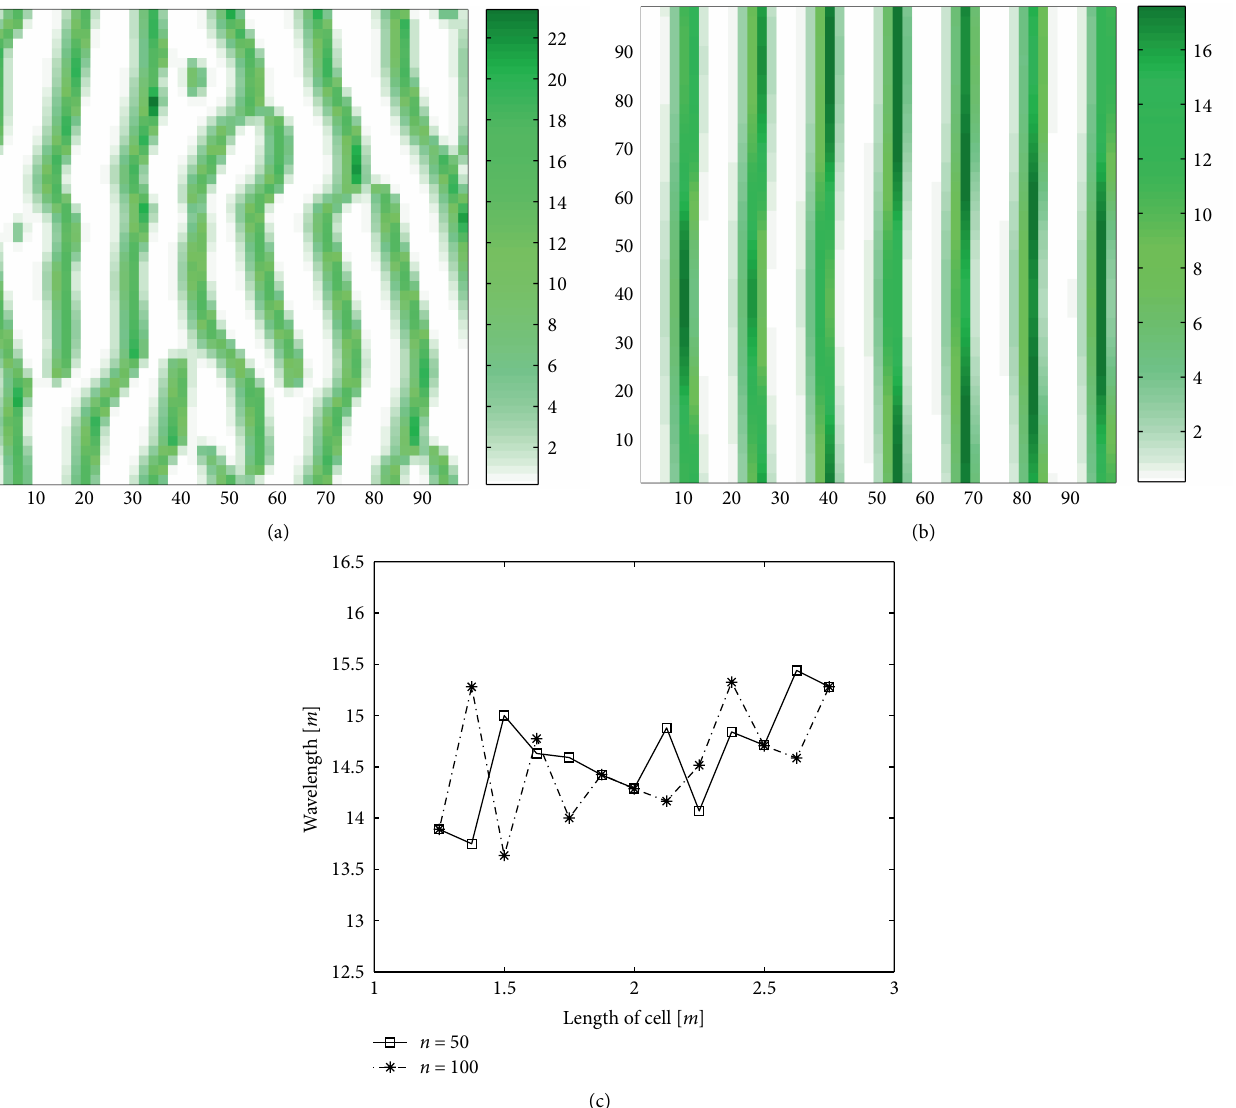
Figure 3: Validation for simulating vegetation pattern formation of the discrete model, with application of same parameter values in Klausmeier [13]. , and the other parameter values is given in Table 2. (a) and (b) are the vegetation patterns at and , 𝑎 = 2, 𝑚 = 0.45 𝑡 = 100 𝑡 = 1000 the downslope direction is set from left to right, (c) change of pattern wavelength with the cell length. Table 3: Comparison of ranges of wavelength and migrating speed for striped vegetation patterns. Tree stripes Grass stripes Property of vegetation stripes Migrating speed Migrating speed Wavelength (m) Wavelength (m) (m year −1 ) (m year −1 ) Present result 25~68 Klausmeier’s result Field